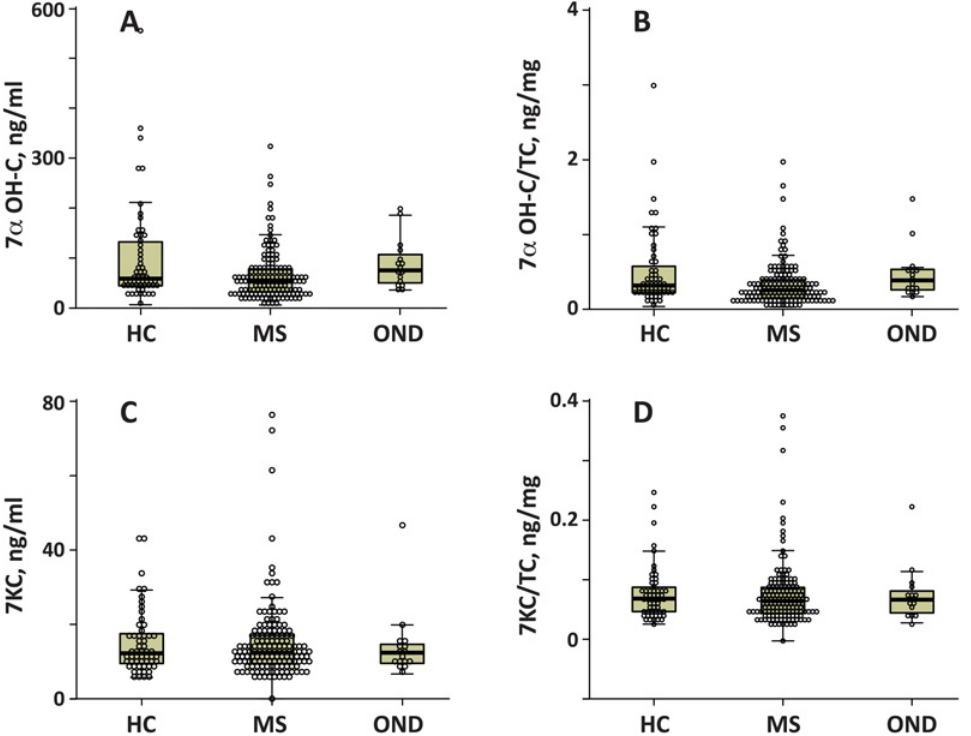
Fig 3. B-Ring oxygenated oxysterol and 25-hydroxy vitamin D3 levels in patient groups. Distribution of 7 α hydroxy cholesterol (7 α HC; Fig 3A) and 7 ketocholesterol (7KC; Fig 3C) and 25-hydroxy-vitamin D3 (25-OHVD 3 ; Fig 3E) for healthy controls (HC), multiple sclerosis (MSC) and other neurological diseases (OND). The results in Fig 3B and 3C correspond to the oxysterols in Fig 3A and 3B, respectively, but are normalized to total cholesterol (TC) levels. The dot-plots for individual patients are superimposed on the box plots. The solid line in the box-plots are the median, the box delineates upper and lower quartiles and the error bar represents the range. Panel A for 7 α HC and Panel B for 7 α HC-TC ratio contains the p-value from the Kruskal-Wallis test in the main body. The inset contains a bar graph and p-values from follow-up Mann-Whitney tests. Panel E illustrates the agreement between 25-OHVD 3 measured by our method on the y-axis compared to a validated LC-MS/MS method on the